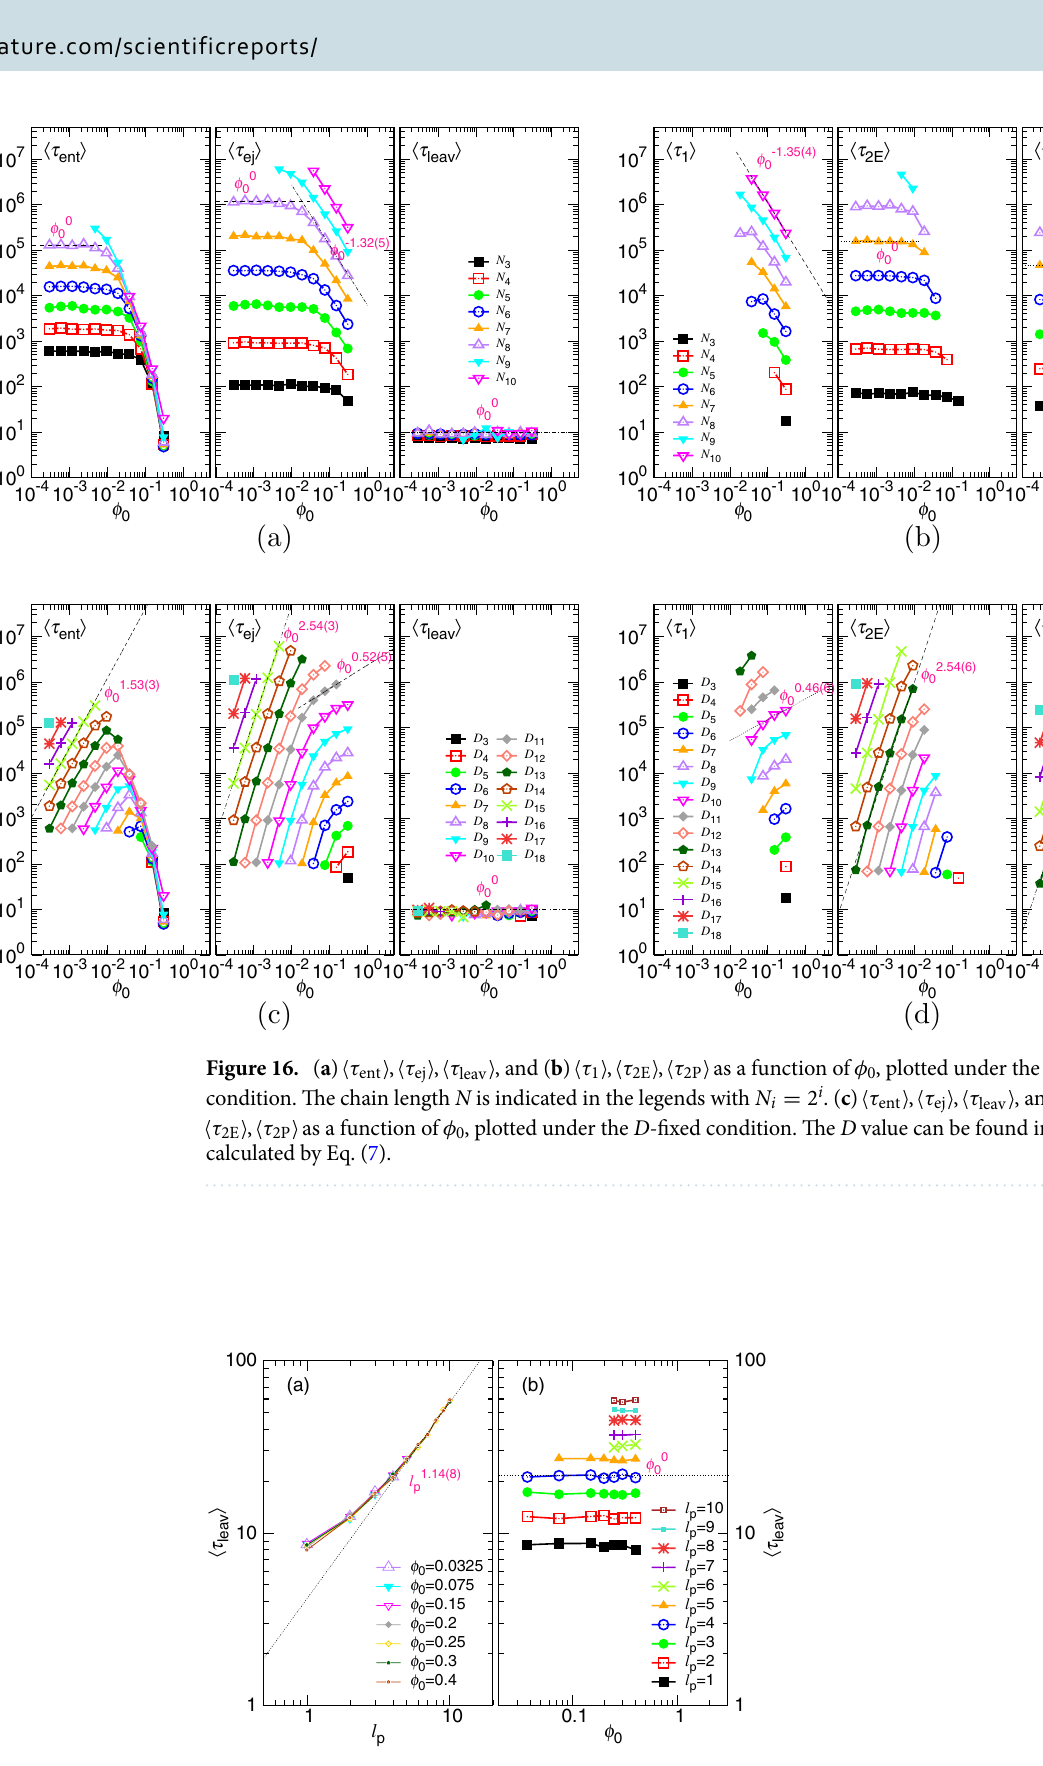
τ leav vs. φ 0 with ℓ p (cid:31) (cid:30)